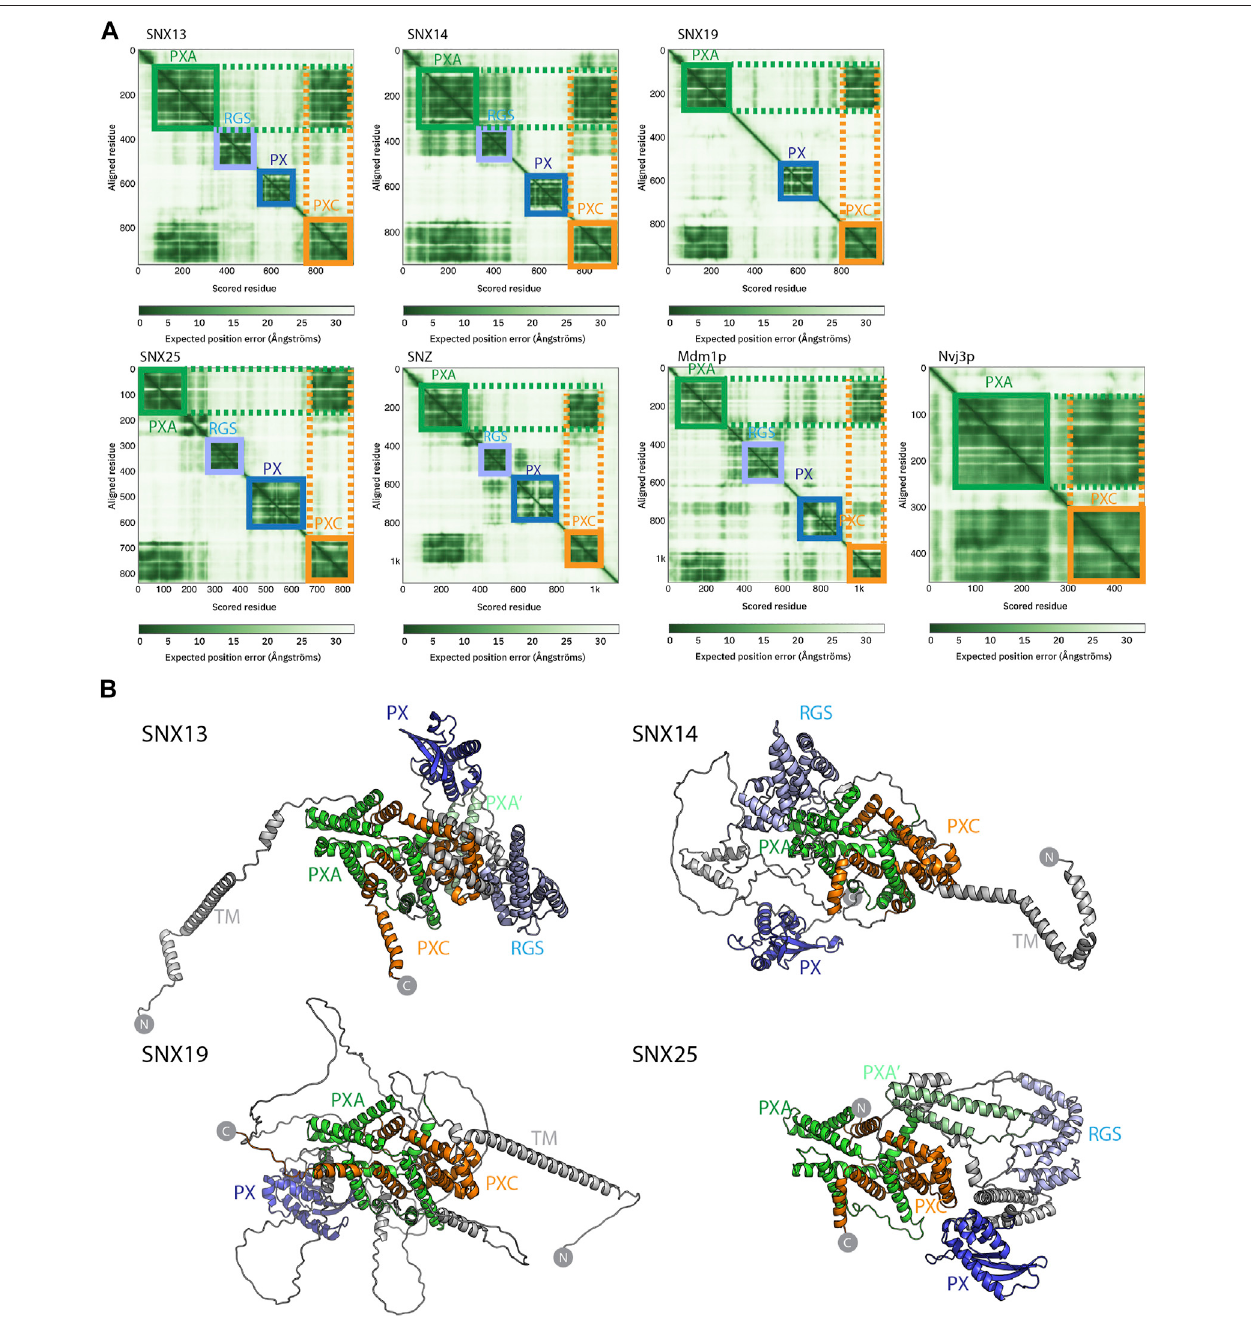
FIGURE 2 | Structures of the SNX-RGS proteins predicted by AlphaFold2. (A) Predicted Alignment Error (PAE) plots from the AlphaFold2 database (Tunyasuvunakool et al., 2021) are shown for human fl y and yeast SNX-RGS proteins. In these plots all SNX-RGS proteinsshow a strong degree of correlation between the PXA and PXC domain suggesting these two domains are physically associated. (B) The predicted structures of human SNX-RGS proteins from the AlphaFold2 database. The PXA domain is coloured green, RGS domain in light blue, PX domain in blue and PXC domain in orange. The predicted TM domain and any unstructuredlinkerregionsarecolouredgrey.ThestructuresareshowninthesameorientationafteralignmentsbasedonthePXAandPXCcoreregion.Thisshowsthat the two domains are intimately entwined with each other, whereas the TM, RGS and PX domains are predicted to have fl exible orientations relative to these domains.